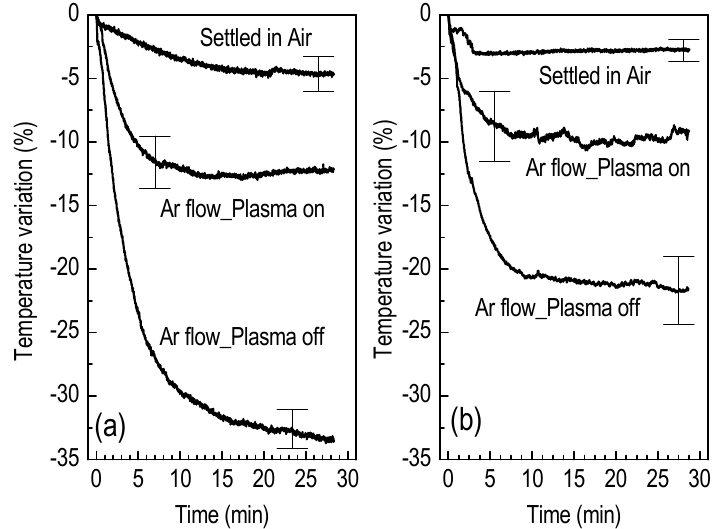
Figure 9. Liquid temperature variation (%) with respect to the ambient temperature versus time in the case of ( a ) DDW and ( b ) PBS. Three different scenarios are examined: (i) liquid settled in ambient air; (ii) liquid is impinged by Ar flow only; (iii) liquid is impinged by Ar plasma jet. Mean values and standard deviations are calculated from two series of experiments carried out on different dates (we show here only the maximum, i.e., the worst case, standard deviation observed in each case). Operating conditions: 11 kV pp , 17.5 kHz, and 1.5 slm.